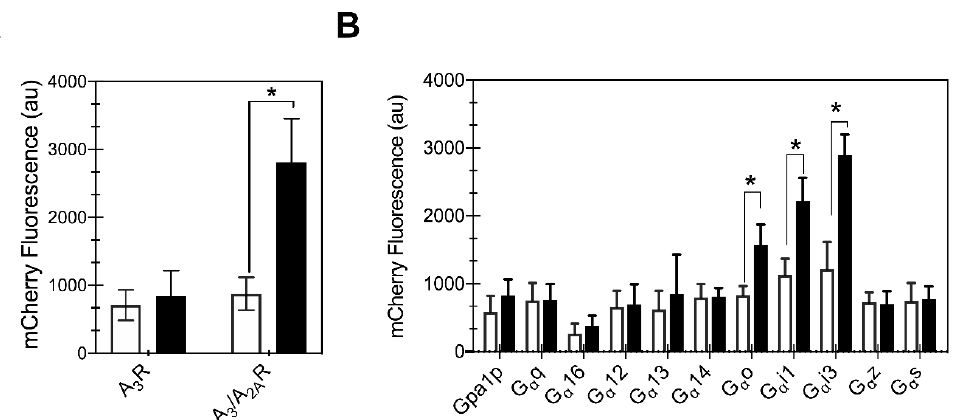
Figure 6. Chimeric receptor signals downstream in yeast upon ligand binding. ( A ) Chimeric A 3 / A 2A R receptor signaling in the presence of agonist (100 µ M NECA, filled bars) compared with control (DMSO, open bars) is significant, whereas wild-type A 3 R shows no detectable signaling. Both signals were measured in engineered yeast (CY13393) expressing the Gpa1p-human G α i1 chimera and the indicated receptor. ( B ) A 3 / A 2A R chimera is activated with native-like coupling to hybrid G α i / o proteins. Results obtained for engineered yeast strains with human / yeast G protein chimeras described previously [17]. The average of three independent transformants performed in duplicates is shown; error bars represent the 95% CI. * represents p -value < 0.05 using Student’s t -test.